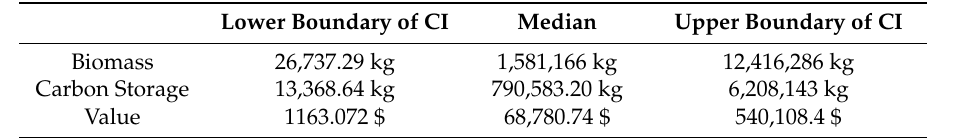
Table 2. Results from the estimation of biomass, carbon storage, and the value as an ecosystem service for the whole investigation area.